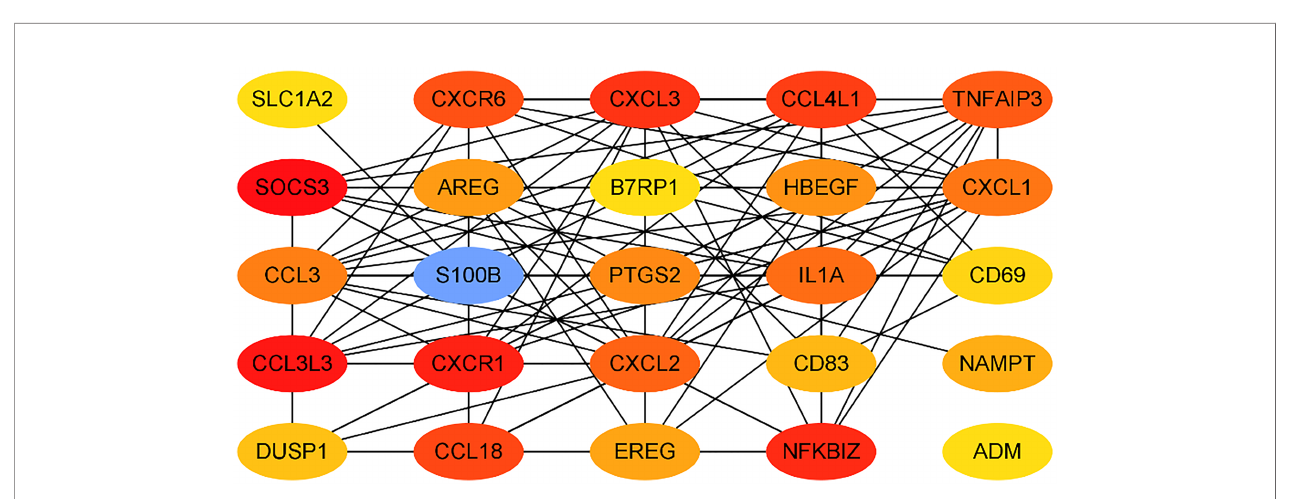
FIGURE 5 | PPI network of the DEGs.